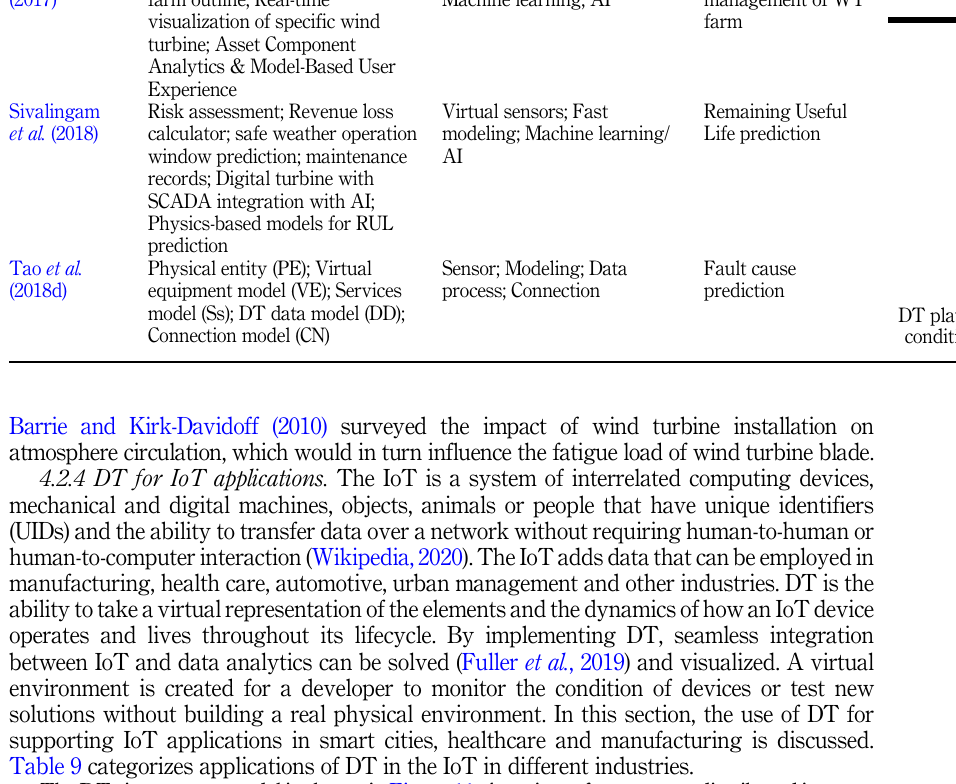
Table 9 categorizes applications of DT in the IoT in different industries.